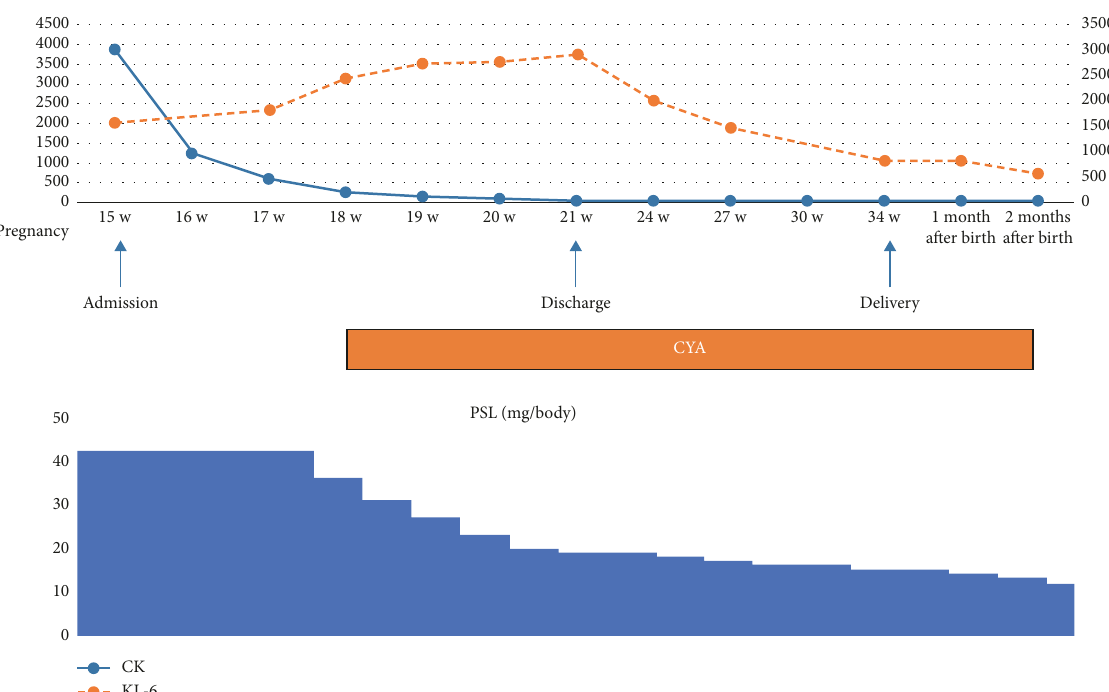
Figure 3: After starting steroid therapy (prednisolone 42mg/day), serum muscle enzyme levels were decreasing, but interstitial lung disease marker levels were increasing. So, administration of concomitant cyclosporine was started at 18weeks of gestation. Prednisolone dose was decreased at a rate of 15%/week. She was discharged at 22weeks and delivered at 34 weeks and 1day of